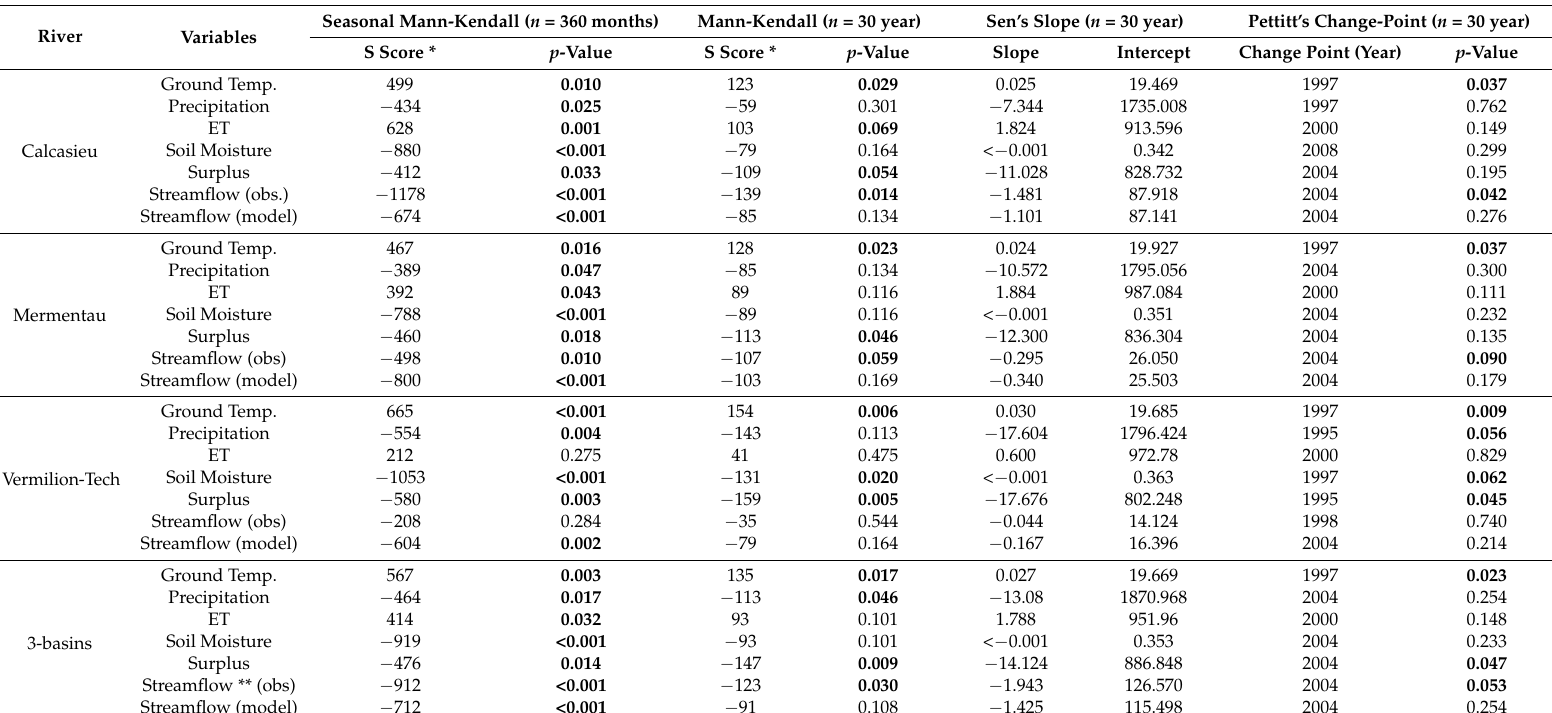
Table 4. Statistics of Trend